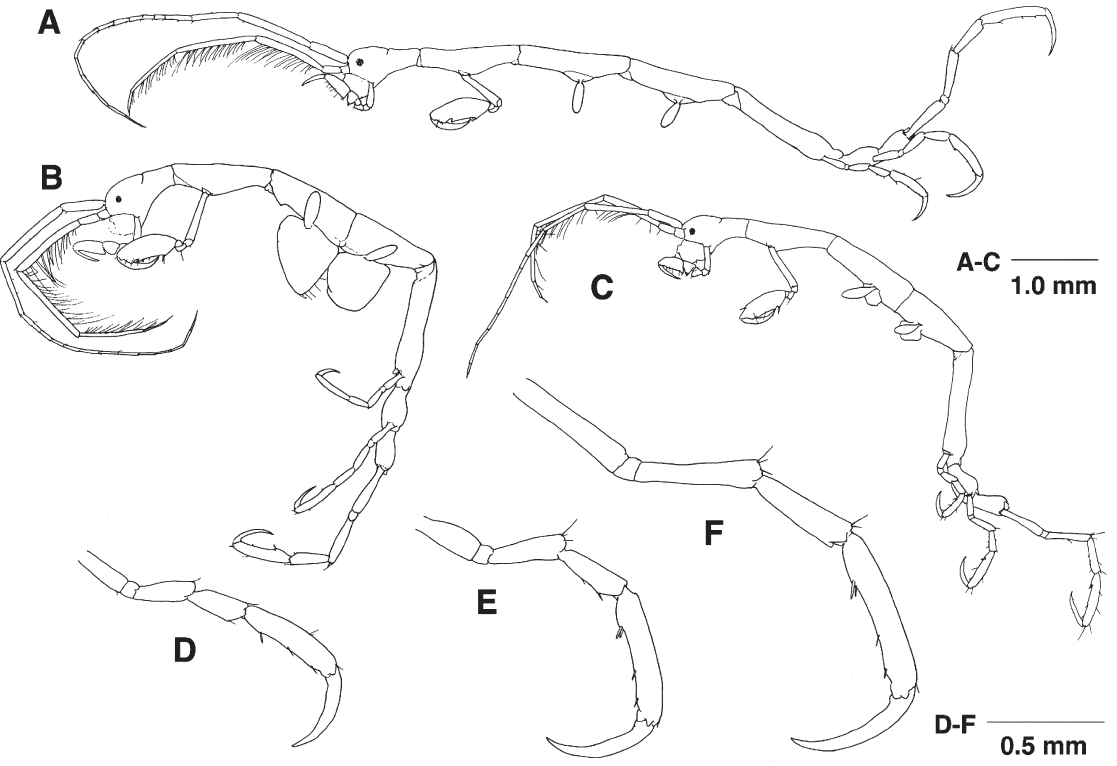
Fig . 1. – Caprella subtilis Mayer, 1903 from 309 m depth in sagami Bay, Japan. a, male “a”; B, mature female “b”; c, premature female “c”; D, pereopod V of male “a”; e, pereopod Vi of male “a”; F, pereopod Vii of male